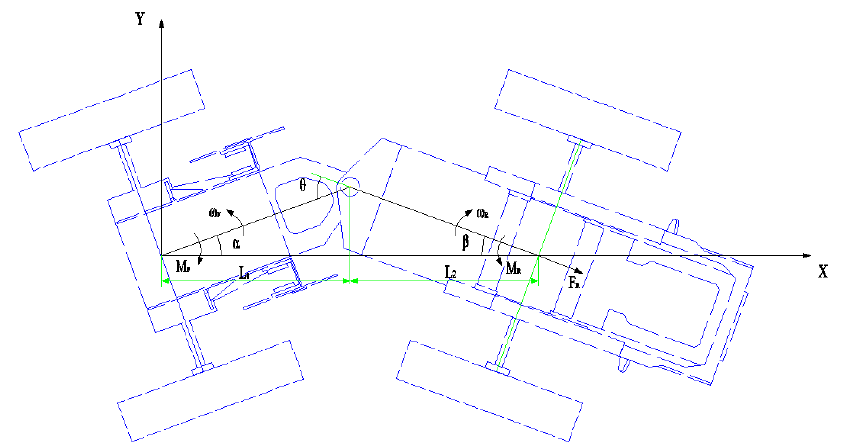
Figure 2. Calculation of steering resistance distance.